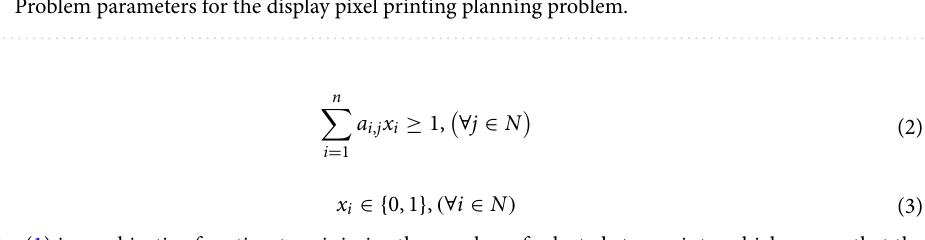
Table 1. Problem parameters for the display pixel printing planning